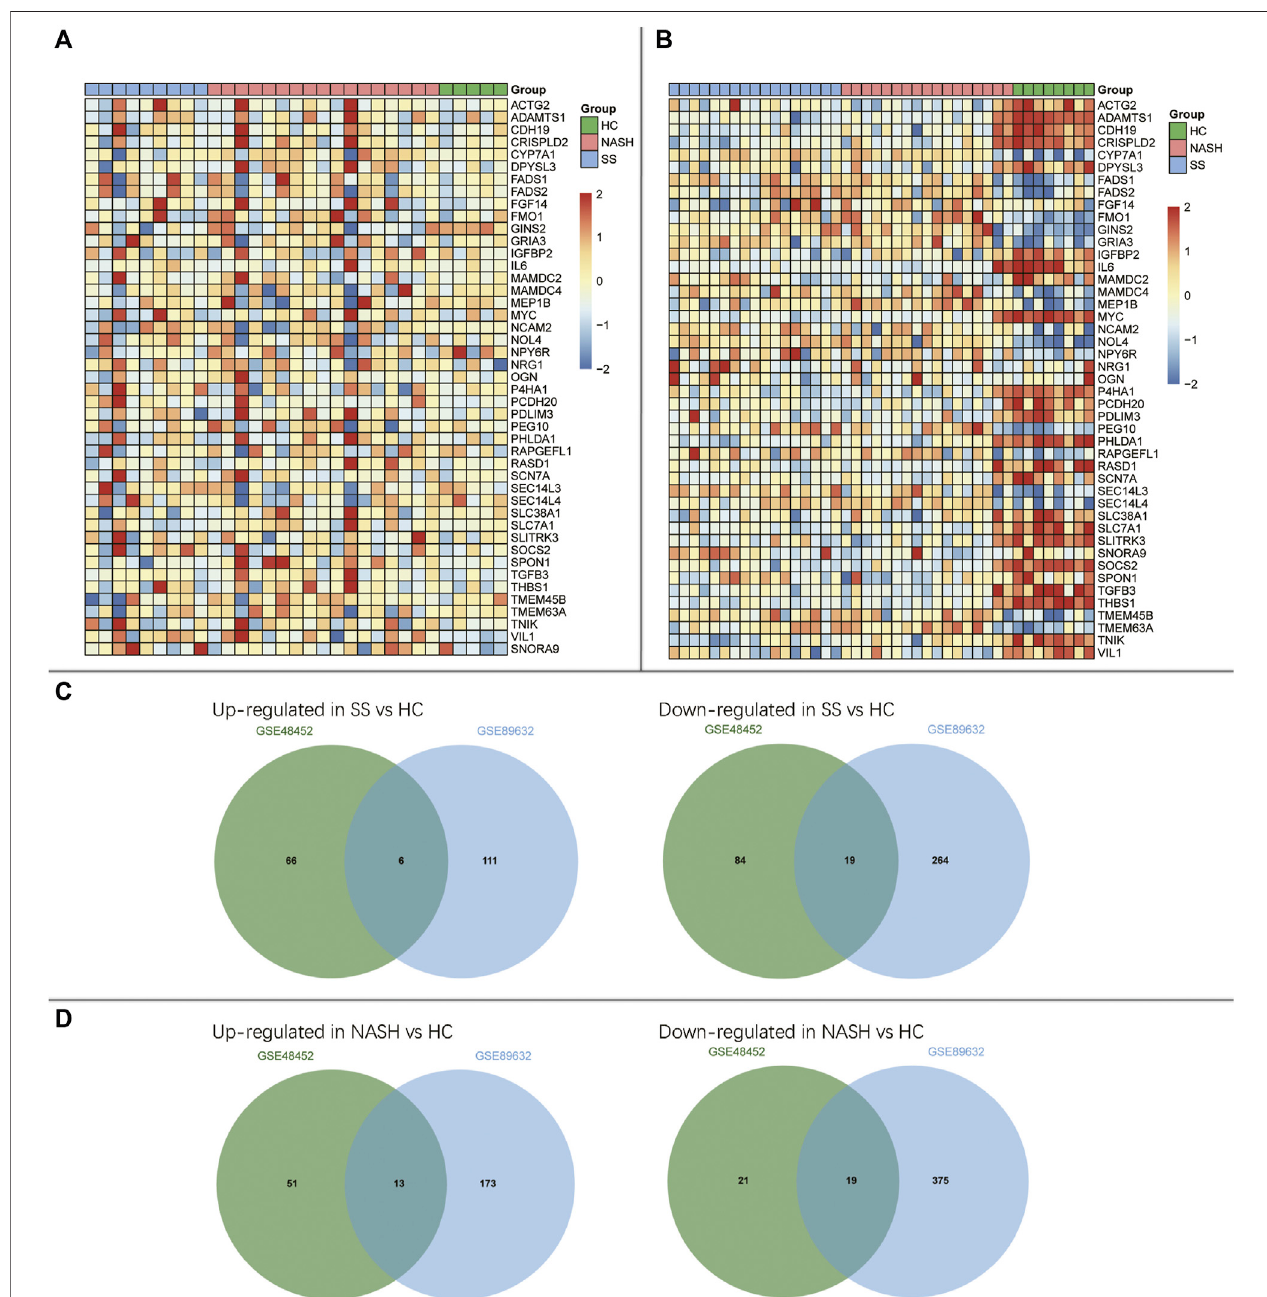
FIGURE 2 | Identi fi cation of differentially expressed genes (DEGs) among HC, SS, and NASH. (A) Heatmap of overlapping DEGs in GSE48452; (B) Heatmap of overlapping DEGs in GSE89632; (C) Venn diagrams displayed the overlapping DEGs of up- and down-regulated genes between HC and SS; (D) Venn diagrams displayed the overlapping DEGs of up- and down-regulated genes between HC and NASH.